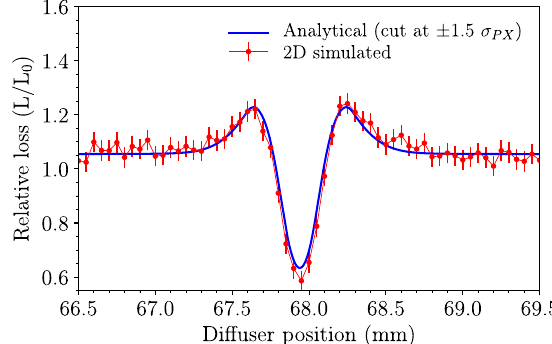
QFA.216.FIG. FIG. 7. Integration of the prototype diffuser in SPS, upstream from the electrostatic septum ES and focusing lattice quadrupole